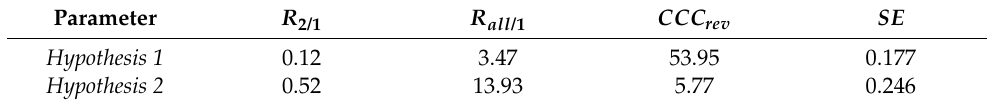
Table 2. Threshold values of metrics for binary classification of hypothesis 1 and hypothesis 2 .